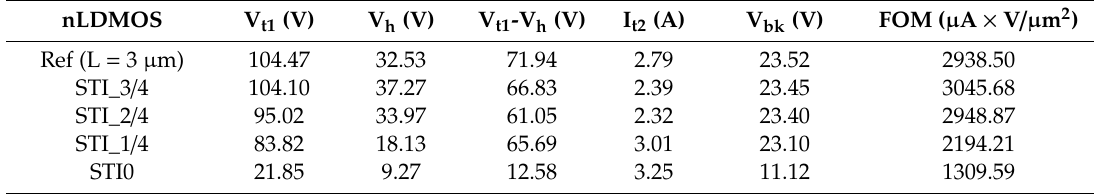
Figure 9. Snapback I-V curves and leakage currents of HV nLDMOSs with drift-region modulation. Table 2. Snapback extracted parameters of HV nLDMOSs with drift-region